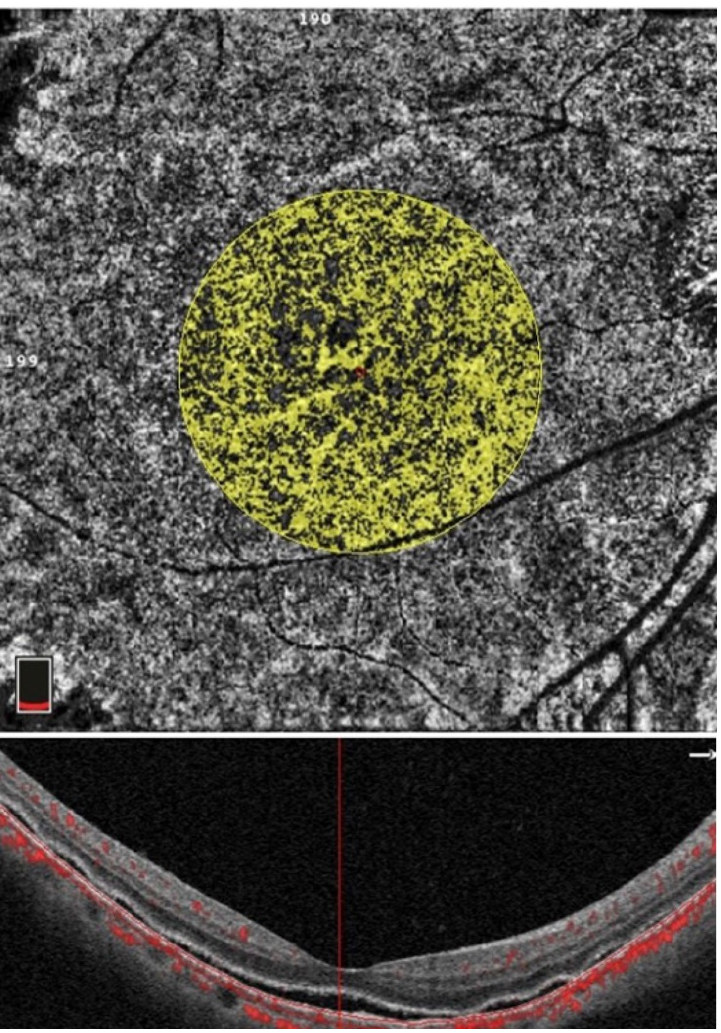
Figure 2. Measurement of the choroidal capillary blood flow density (CCFD). The flow area in the circle of 1.50 mm radius of choriocapillaris is measured, and the CCFD is obtained by the ratio of flow area to the selected area.